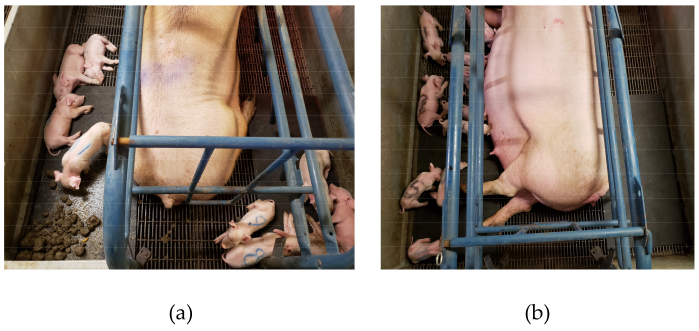
Figure 1. Control ( a ) and deprived ( b ) litters with and without maternal feces